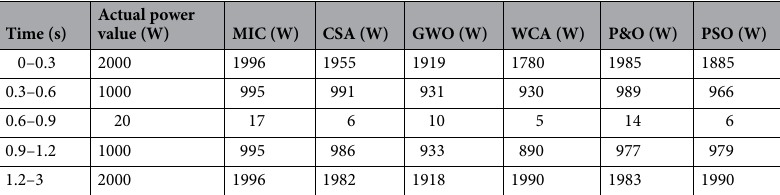
Table 4. The output power of solar modules at changes radiation conditions.